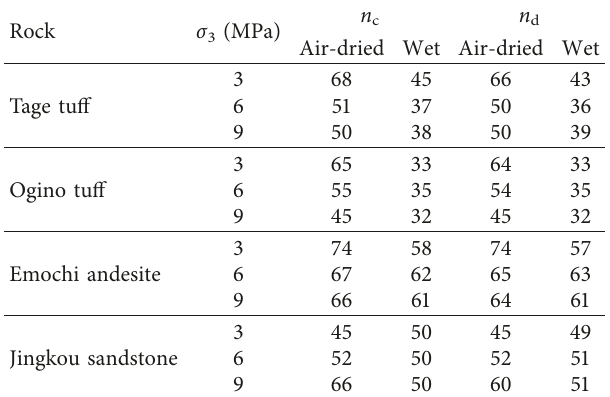
Figure 6: Sketch of stress corresponding points in the postfailure region [16]. Dotted lines correspond to constant strain (a), line passing through the origin (b), line with slope equal to Young’s modulus (c), and unload modulus (d). Table 3: Calculated results of n c and n d .